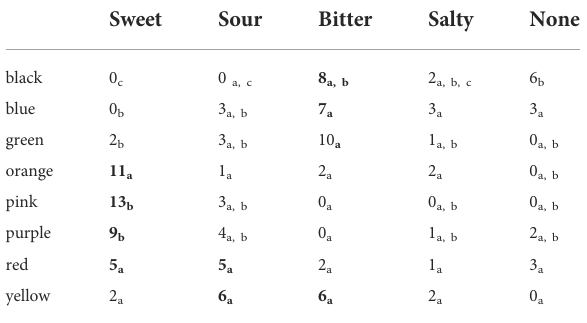
TABLE 2 The frequencies and pairwise comparisons of the answers to Q2-2 in Experiment 2. The values in bold indicate the most frequently selected taste. Each subscript letter denotes a subset of color categories whose proportions do not differ signi fi cantly from each other at the 0.05 level reading across a